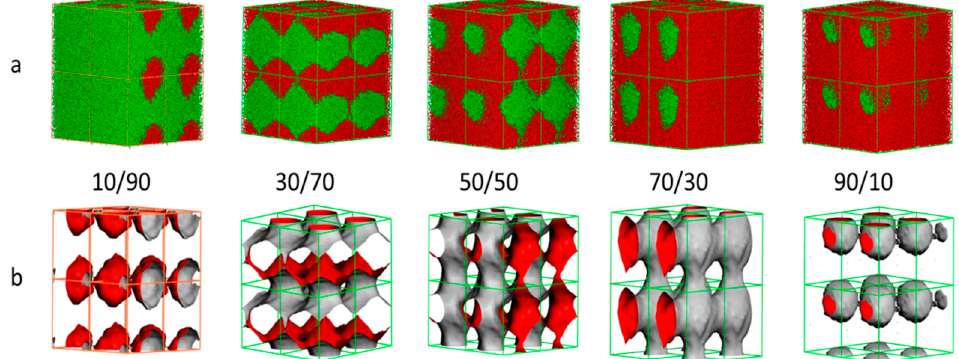
Figure 7. Morphologies ( a ) and iso-surface ( b ) of the NR/CR blends with different mass ratios. (In Figure 7a, red represents NR particles, and green represents CR particles. In Figure 7b, red represents the CR iso-surface, and gray represents the NR iso-surface.)